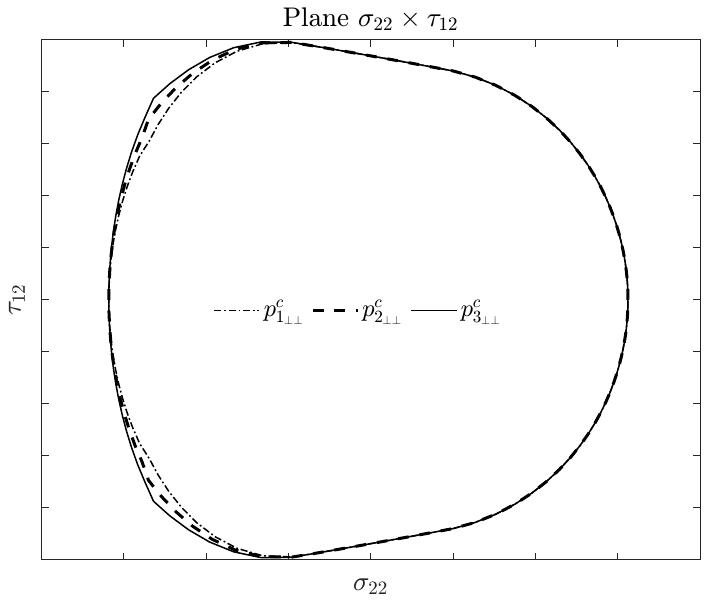
× τ 12 failure envelope. ⊥⊥ on the stress space σ 22 = 0.3, p c = 0.25 and p c = 3 ⊥⊥ 2 ⊥⊥ 1 ⊥⊥